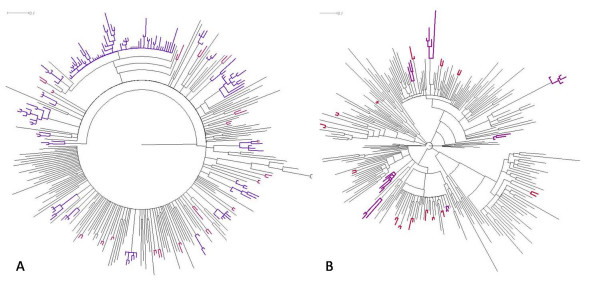
Bayesian phylogenetic tree. Panel A: Subtype B infections; Panel B: Non-B Subtype infections. Transmission clusters are indicated in purple, transmission pairs in red.